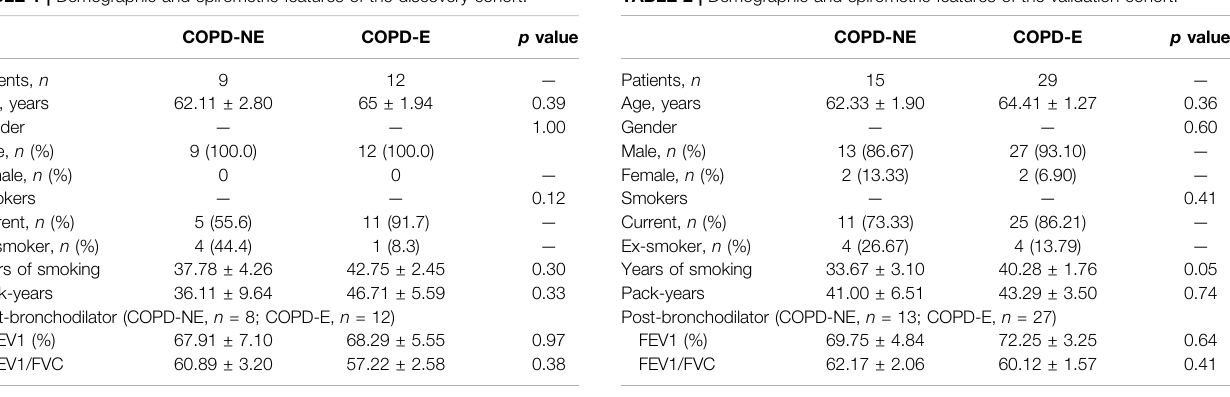
Data represent the mean ± SEM of demographic and spirometric features of all patients in each group; COPD, chronic obstructive pulmonary disease; FEV1, forced expiratory volume in 1 s; FVC, forced vital